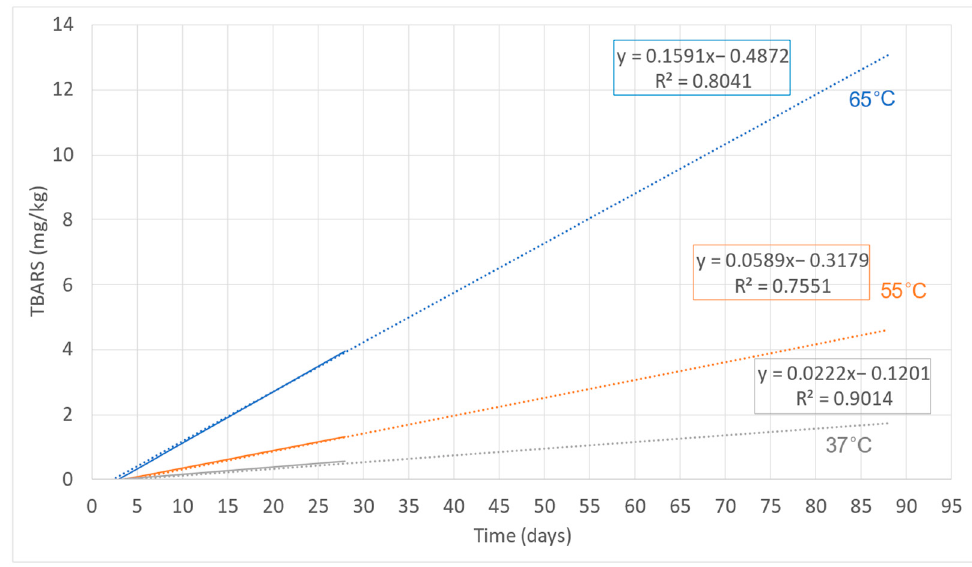
Figure 2. Linear adjustment and projection of TBARS values obtained in the MDDM at different days and temperatures (37, 55, and 65 °C).